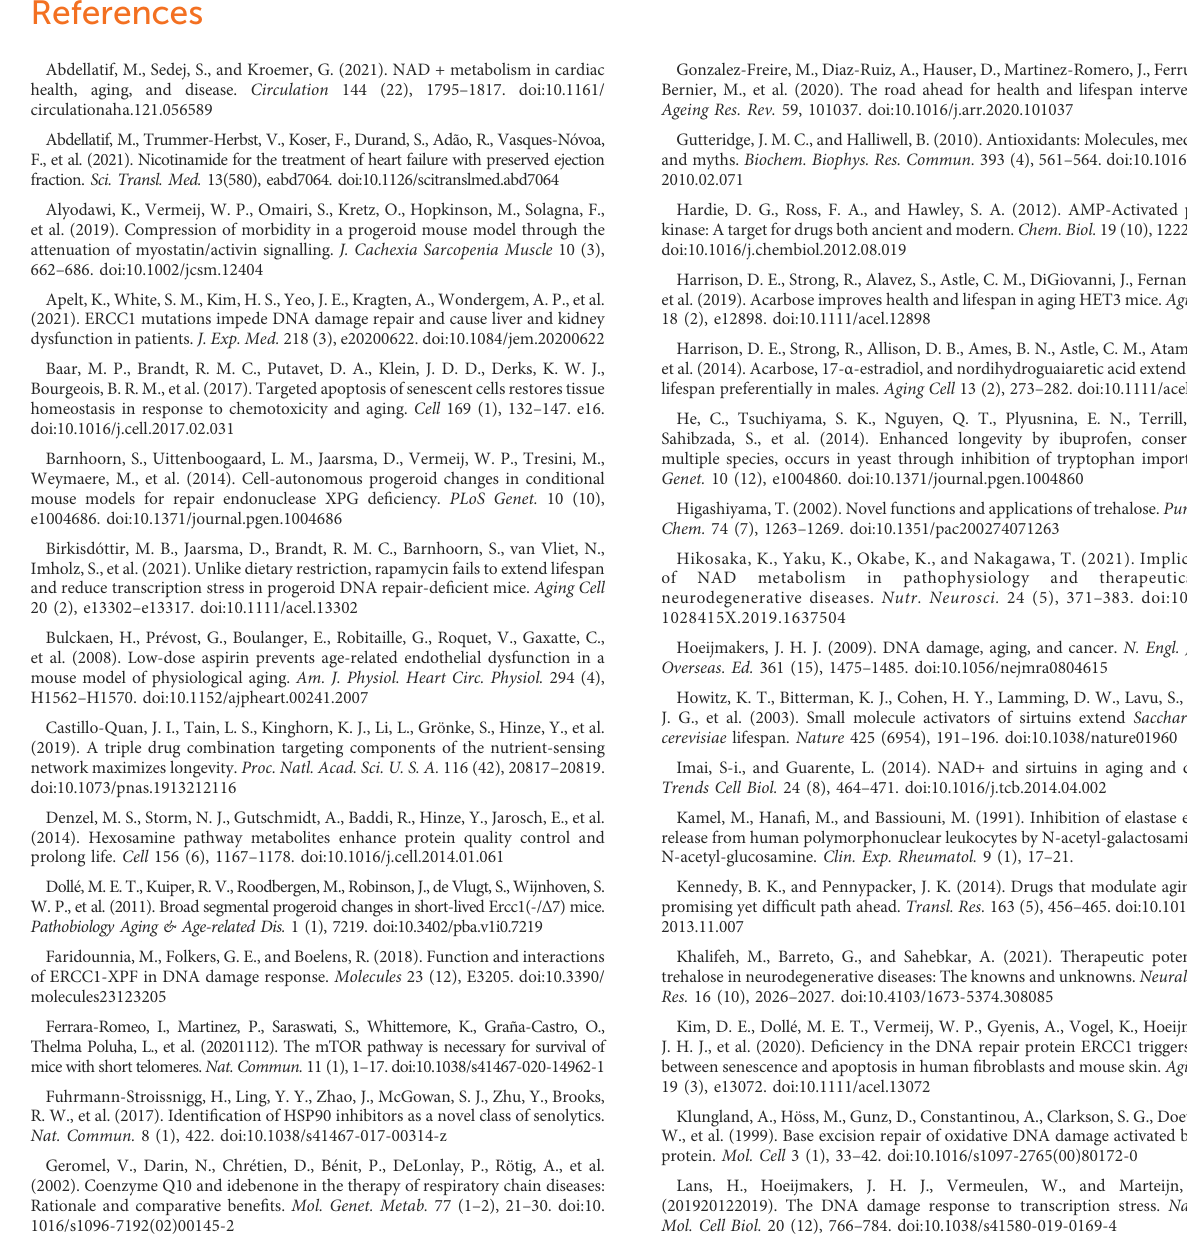
SUPPLEMENTARY FIGURE S6 Statistical testing on the effect of gender on treatment ef fi ciency per